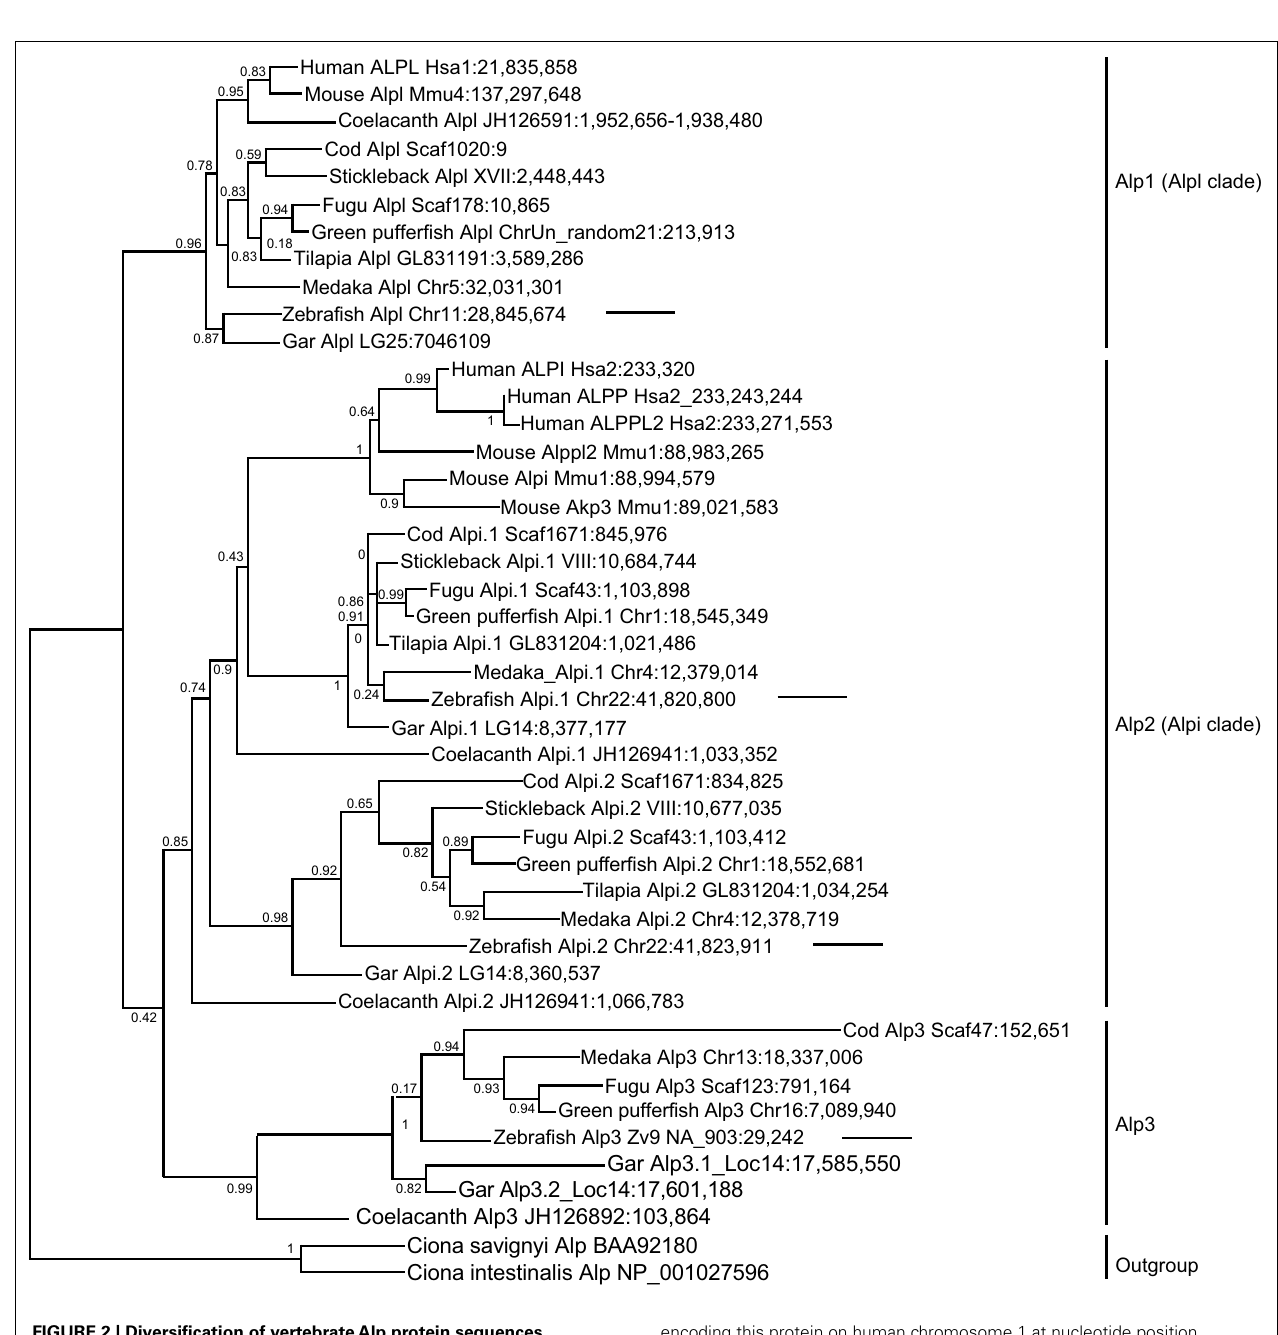
FIGURE 2 | Diversification of vertebrateAlp protein sequences. Sequences are indicated on this maximum likelihood tree with the species name, gene name, and genomic location. For example, the taxon “Human ALPL Hsa1:21,835,858” indicates the start of the human ALPL gene